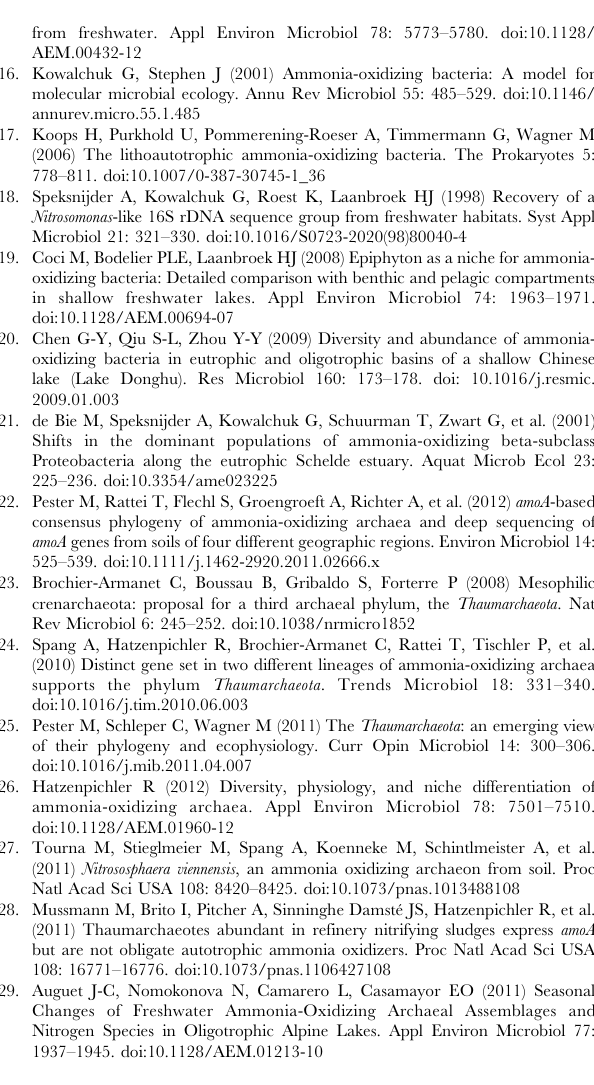
Figure S1 Overview over sequence analysis. Figure S2 Neighbor-joining tree of the AOA amoA nucleotide sequences. Figure S3 Neighbor-joining tree of the AOB amoA nucleotide sequences. Figure S4 UPGMA clustering of weighted unifrac dis- tance of the AOB amoA sequences in Lake Erie.